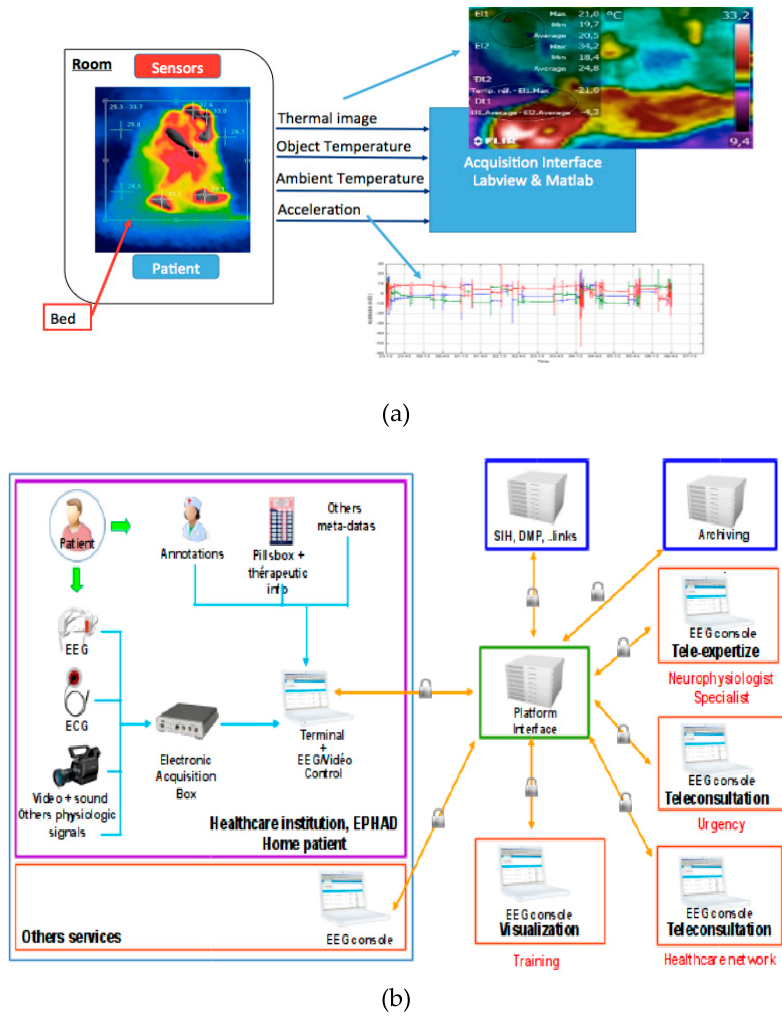
Figure 1. ( a ) Experimental setup for data collection overnight sleep. ( b ) The measurement